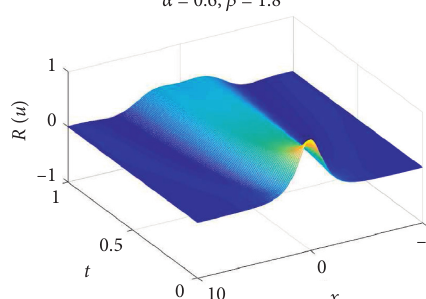
Figure 10: The trace of the solution to the real part of u with α � 0 . 8 and β � 1 . 2.